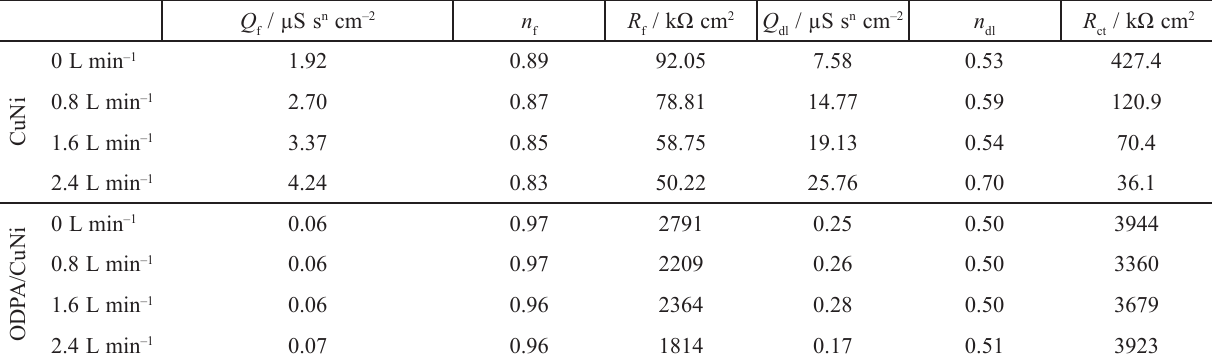
Table 1 – Impedance parameters obtained for CuNi alloy in river